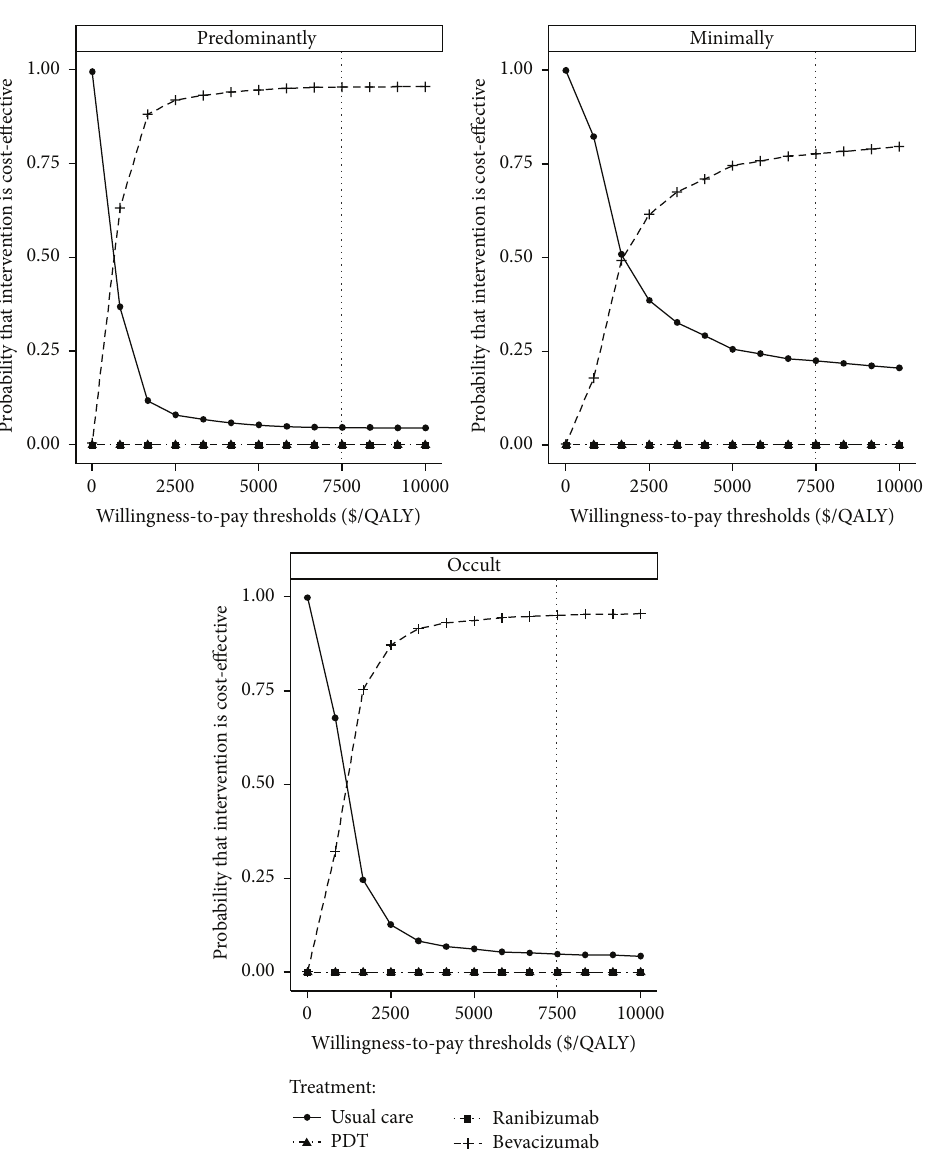
Figure 3: The cost-effectiveness acceptability curves for the four treatment strategies. The 𝑦 -axis indicates the probability that a strategy is cost-effective against the willingness to pay per QALY gained ( 𝑥 -axis). The vertical dotted line represents the thresholds for